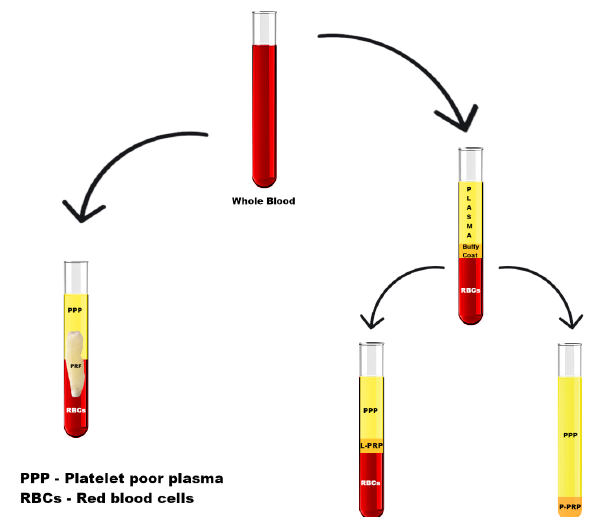
Figure 1. Differences in the methods of obtaining PRF, L-PRP and P-PRP from blood. The left side of the figure reveals the procedure for obtaining PRF, while the right side shows the differences in obtain- ing P-PRP and L-PRP. PRF: platelet-rich fibrin, P-PRP: Pure platelet-rich plasma, L-PRP: Leukocyte- and platelet-rich